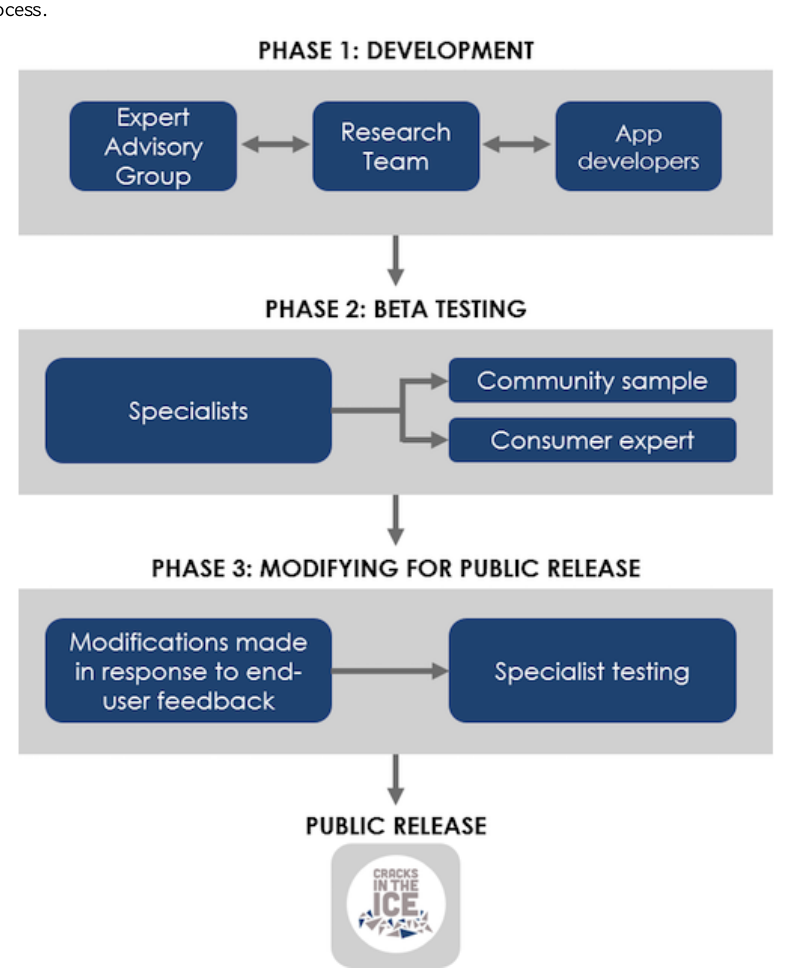
Figure 1. The co-design